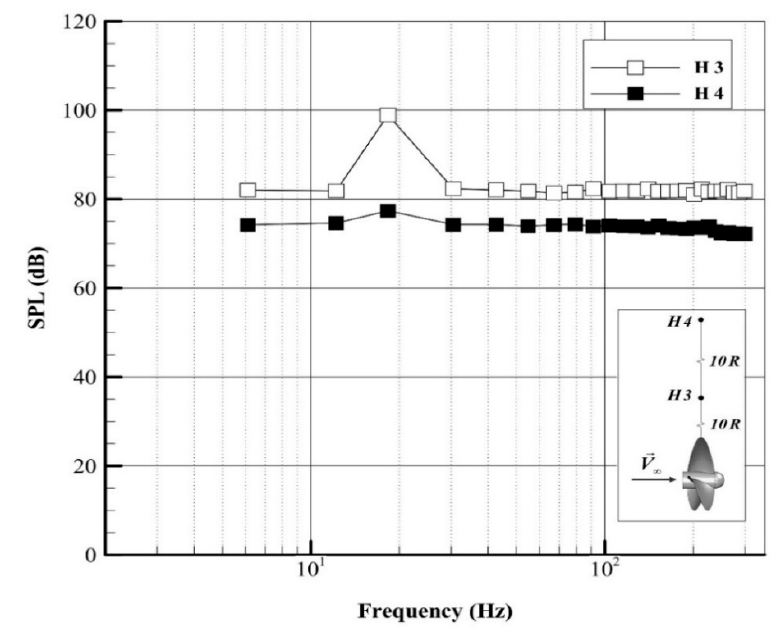
Figure 16. Sound pressure level of propeller in hydrophones H3 and H4.